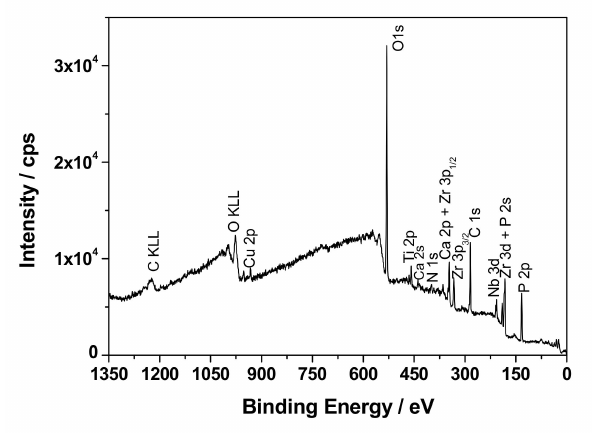
Figure 5. The XPS survey spectrum of the ZrNb-500